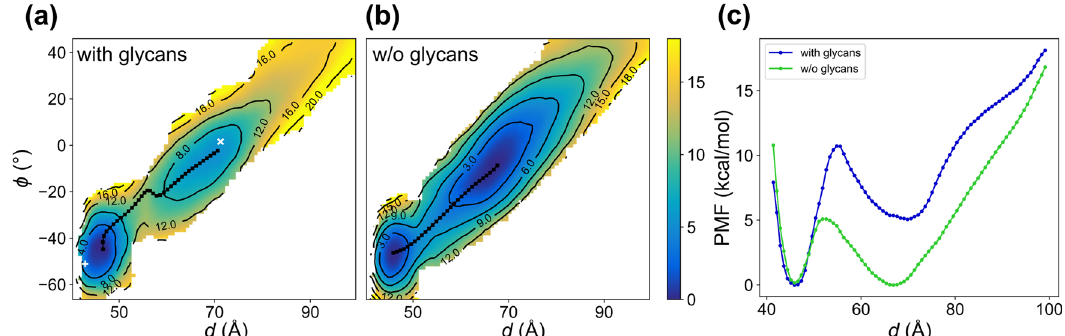
Fig. 2 PMFs describing the opening of RBD-A. a , b The 2D PMFs of the a glycosylated and b un-glycosylated systems along two collective variables, d and ϕ , de fi ned to describe the opening of RBD-A (Fig. 1c, d). The location of the down- (6XR8) and up-state (6VYB) cryo-EM structures are indicated in a with a " + '' and "x'' sign, respectively. The black dotted line shows the MEP for each system. c The free energies are projected onto d and plotted as 1D PMFs. See also Supplementary Data 1.